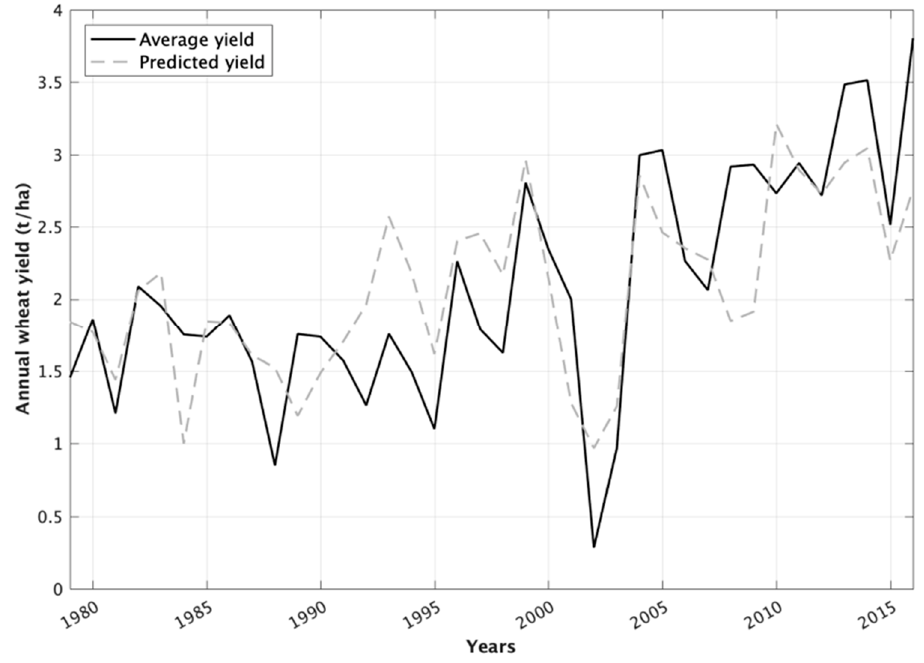
Figure 15. Average vs. predicted yield for rural municipality # 469 (1979–2016) (Black soil zone).